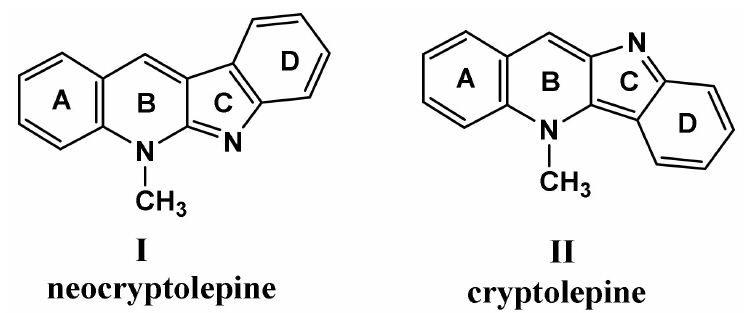
Figure 1. Indoloquinolines from Cryptolepis sanguinolenta.